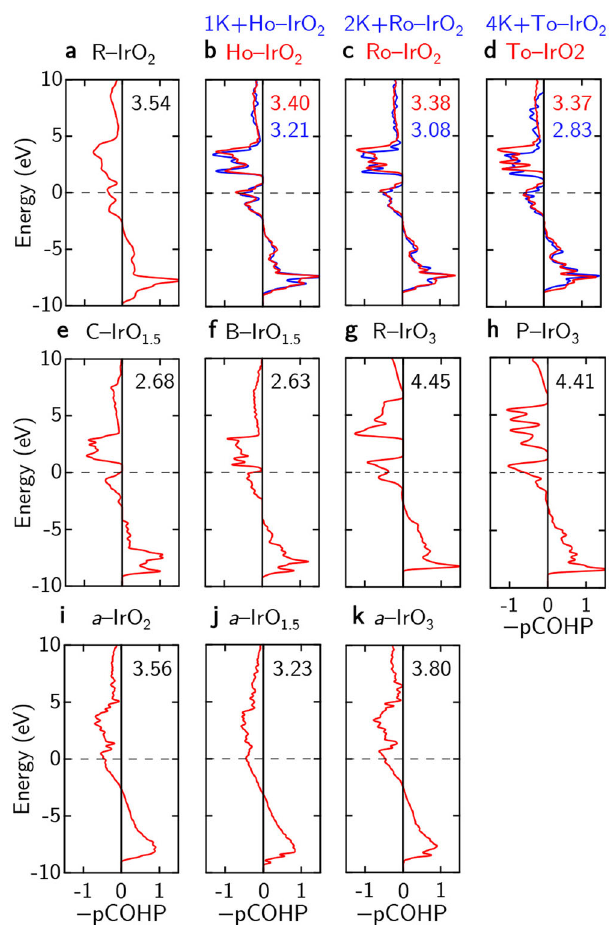
Fig. 5 Averaged projected crystal orbital Hamilton population ( − pCOHP) between the Ir and O atoms. a R-IrO 2 , b Ho-IrO 2 , c Ro-IrO 2 , d To-IrO 2 , e C-IrO 1.5 , f B-IrO 1.5 , g R-IrO 3 , h P-IrO 3 , i a -IrO 2 , j a -IrO 1.5 , and k a -IrO 3 . For each pCOHP plot, the (negative) integrated pCOHP ( − IpCOHP) values (up to the Fermi level) is also indicated in the top-right hand corner. For the case of nanoporous IrO 2 , the − pCOHP curves and − IpCOHP values are denoted red and blue for the pristine and K-intercalated structures, accordingly. The Fermi level is set to zero in all pCOHP